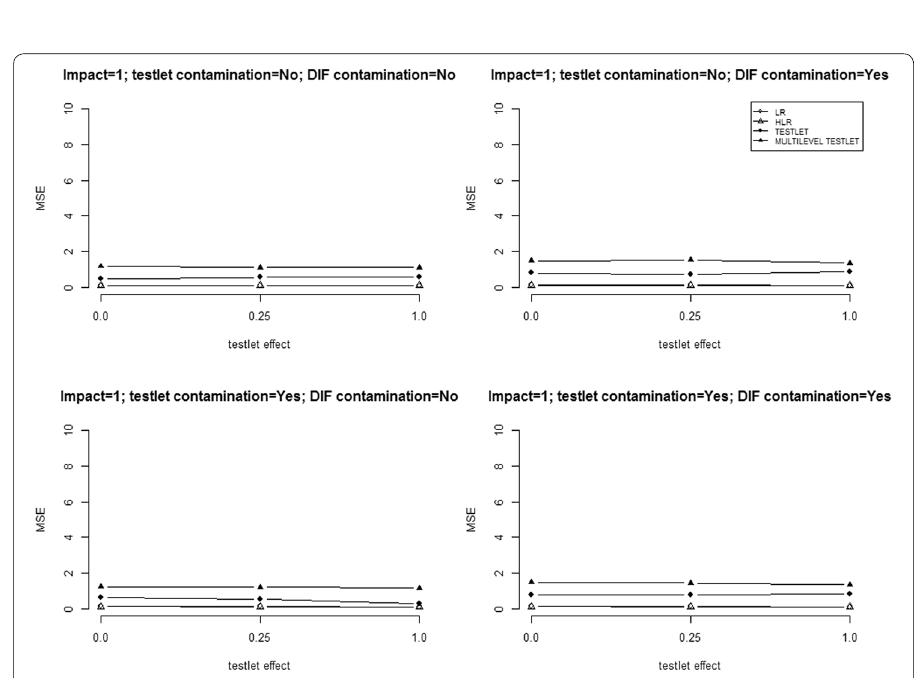
Fig. 7 Effects of testlet contamination and DIF contamination at each level of item clustering effect when there is impact between